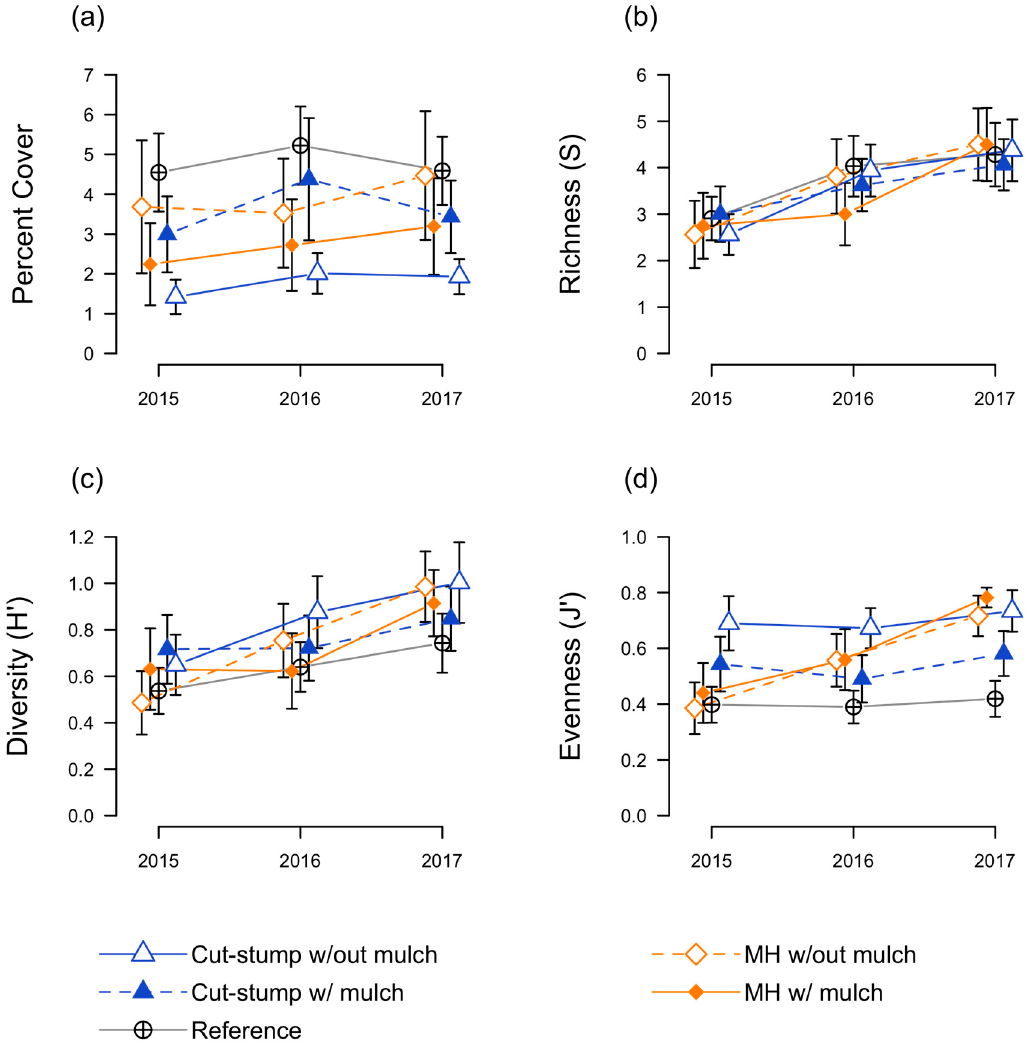
Figure 5. Percent cover ( a ) and diversity indices ( b – d ) of spring perennial herbaceous plants prior to invasive shrub removal (2015) and following shrub removal (2016–2017) accomplished using cut-stump or forestry mulching head (“MH”) treatments, with mulch removed/absent or added/present. Invasive shrubs were not removed in reference areas for comparison. Dashed lines indicate management techniques with mulch manipulated (added/removed) and solid lines represent operational (no mulch manipulation) management techniques. Values are means ± standard error. Data were collected from mid-July to late August at four mature secondary hardwood forest sites near West Lafayette, Indiana, USA.